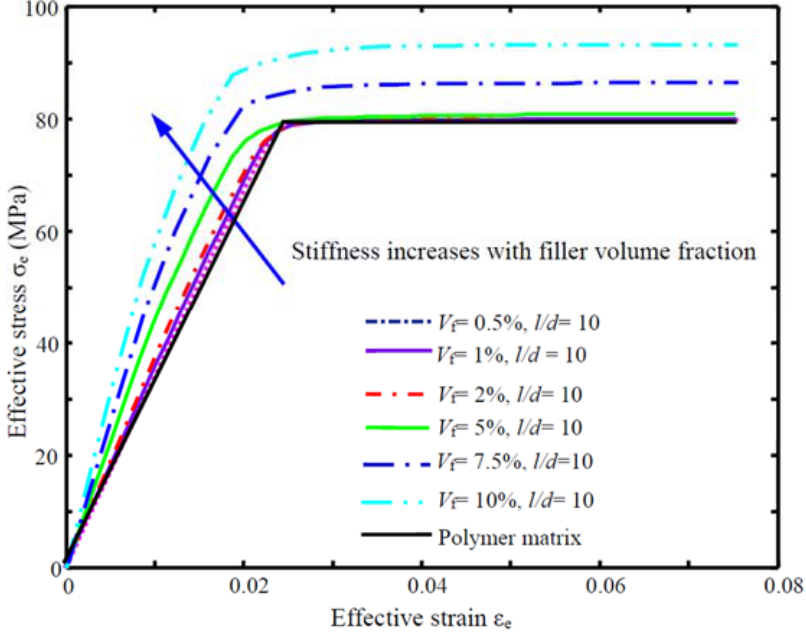
Figure 9. Effective stress-strain diagram σ e - ε e of the PNCs with the clay-particle aspect ratio ρ = 10 (plane-stain, case I).